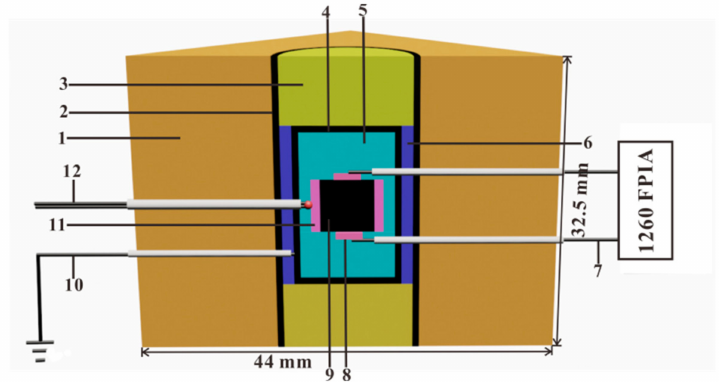
Figure 4. Experimental assemblage for EC measurements in the YJ-3000t multi-anvil press. (1) pressure medium of cubic pyrophyllite (baked at 973 K); (2) three layers stainless steel heater; (3) symmetric pyrophyllite block (baked at 1173 K); (4) metallic shielding case made of Ni, Fe, Re or Mo foil; (5) MgO insulation tube; (6) Al 2 O 3 insulation tube; (7) lead wire of metallic electrode and Al 2 O 3 insulation tube; (8) two symmetric bu ff er electrodes; (9) sample; (10) electric grounding; (11) solid oxygen bu ff er; (12) thermocouple and Al 2 O 3 insulation